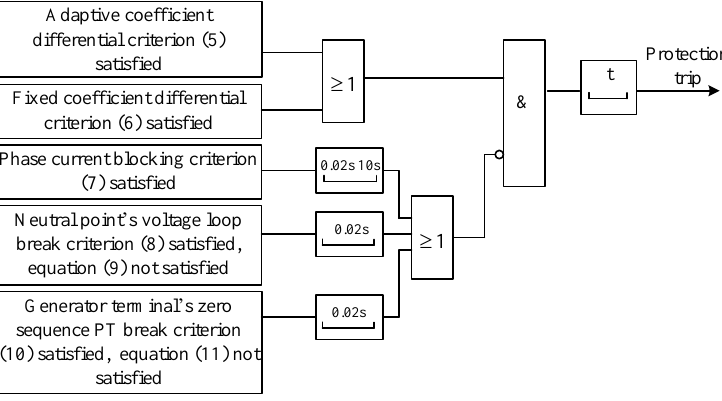
Figure 7. Logic diagram of the new protection scheme.